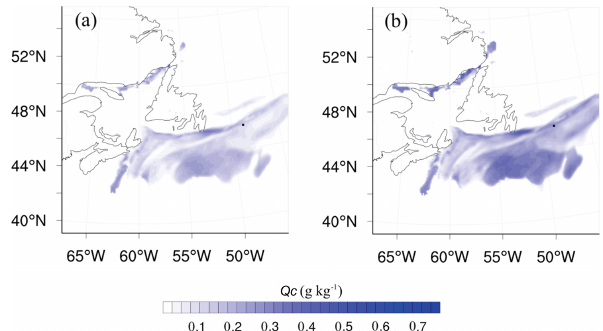
Figure 4. The 2-D fog plots at lowest model level on 1 July 2018, 18:00Z, from WRF. Thompson microphysics with gravitational de- position (a) with z 0c = 0 . 01m and no turbulent deposition (b) is re- lated to Fig. 5a. The black dot shows the point on the Grand Banks to which the profiles in Fig. 5 correspond.